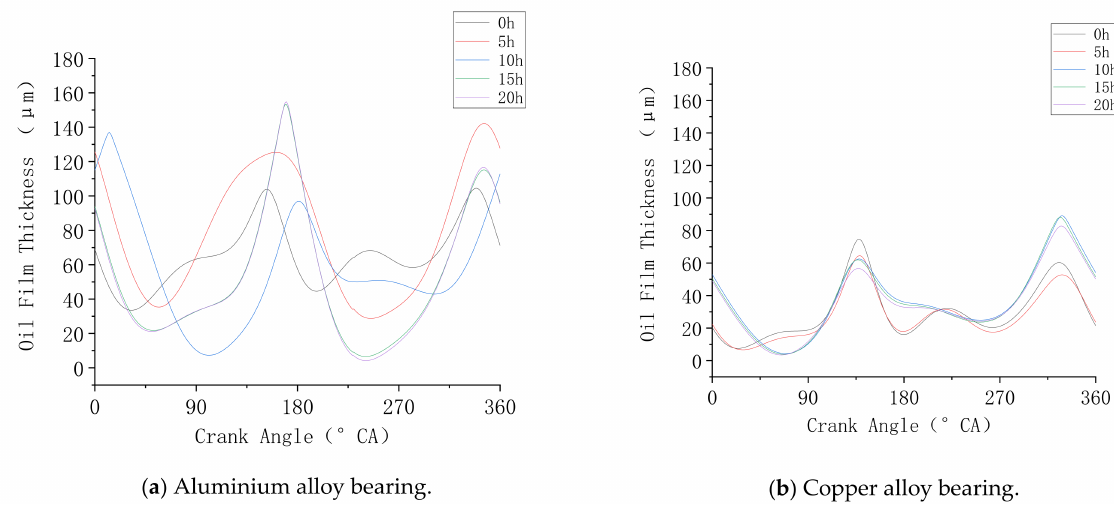
Figure 14. Comparison of oil film thickness of different bearings with different times.